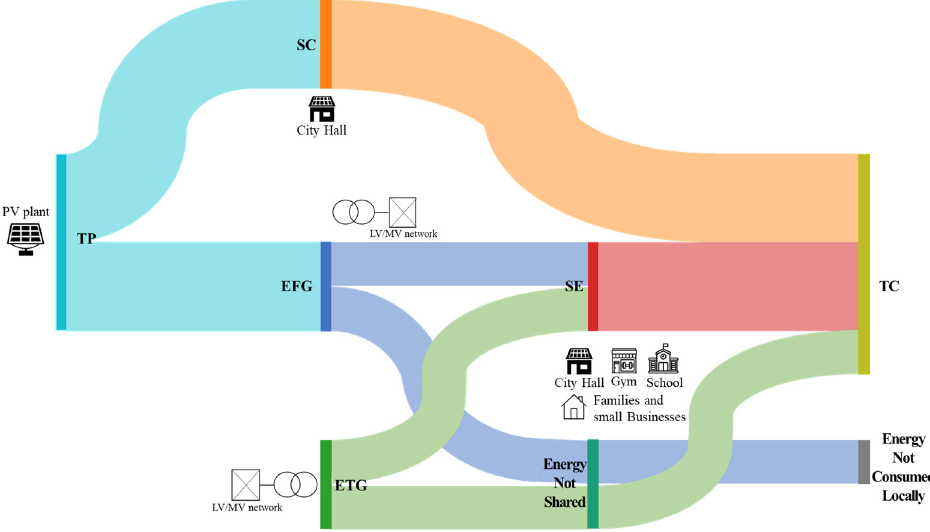
Figure 3. Energy flows, relevant parameters, facilities, and members of the community.